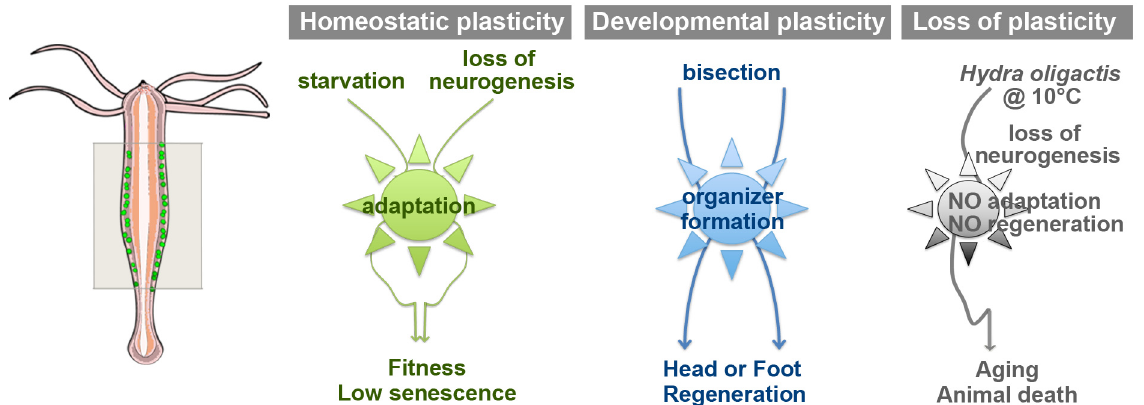
Figure 1. Homeostatic and developmental plasticity in Hydra . The scheme represents the typical epithelial bilayered anatomy of Hydra polyps with interstitial stem cells (green dots) distributed along the central body column (framed box). By contrast cells at the apical and basal extremities are terminally differentiated. A highly dynamic homeostasis with continuous renewal of stem cells supports the fitness and the low senescence of Hydra . Animals survive long periods of starvation as well as the elimination of the nervous system if force-fed. After bisection at any level along the body column, the stump is able to reestablish an organizer centre and regenerate the missing part, either basal or apical. However, some Hydra oligactis strains show a very low level of plasticity: they do not adapt to the loss of neuronal progenitors induced by the transfer to cold temperature, they rapidly lose the ability to regenerate, undergo aging, and finally die in a couple of